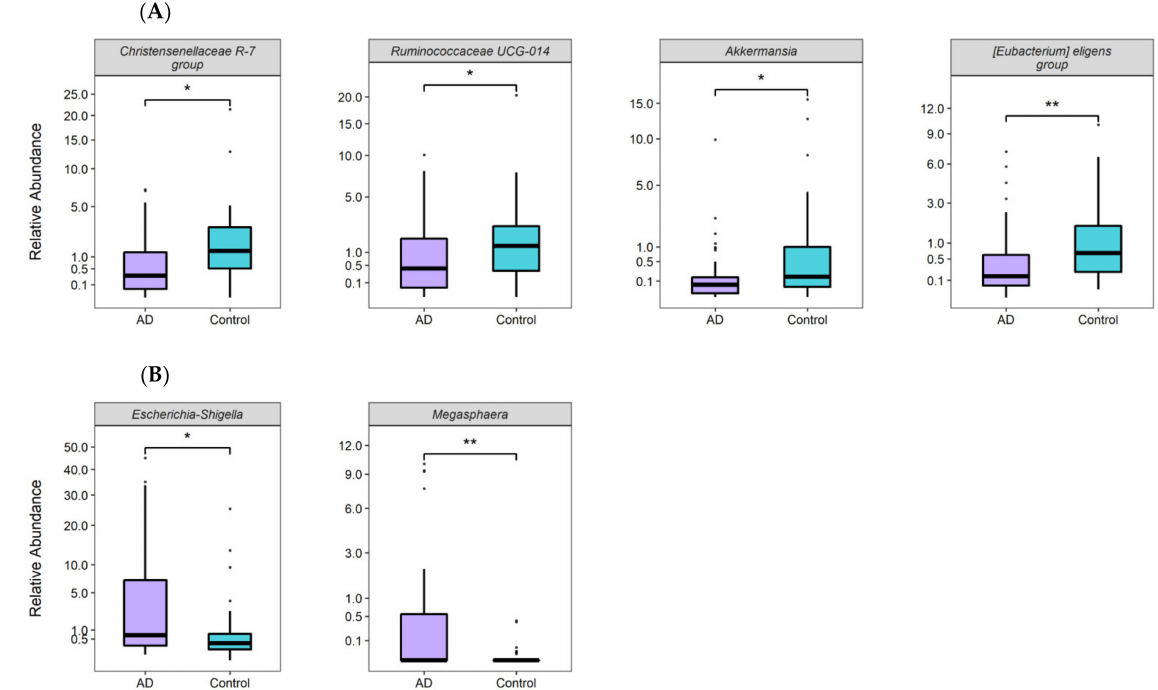
Figure 4. Relative abundance of differentiated genera (LDA score >3.5; p -value < 0.05) between AD individuals and controls. ( A ) Bacterial genera significantly more abundant in controls; ( B ) bacterial genera significantly more abundant in subjects with AD. * p < 0.05; ** p < 005.